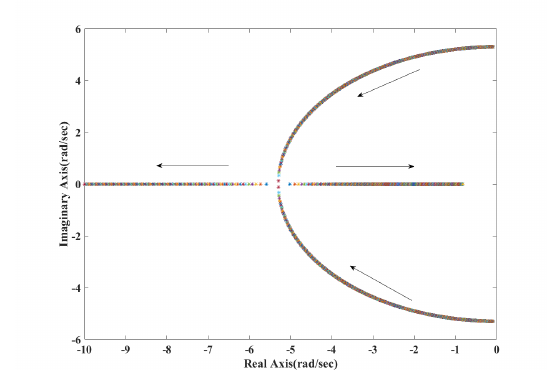
Figure 9. m = 0.4 and K p increases from 0.1 to 20.